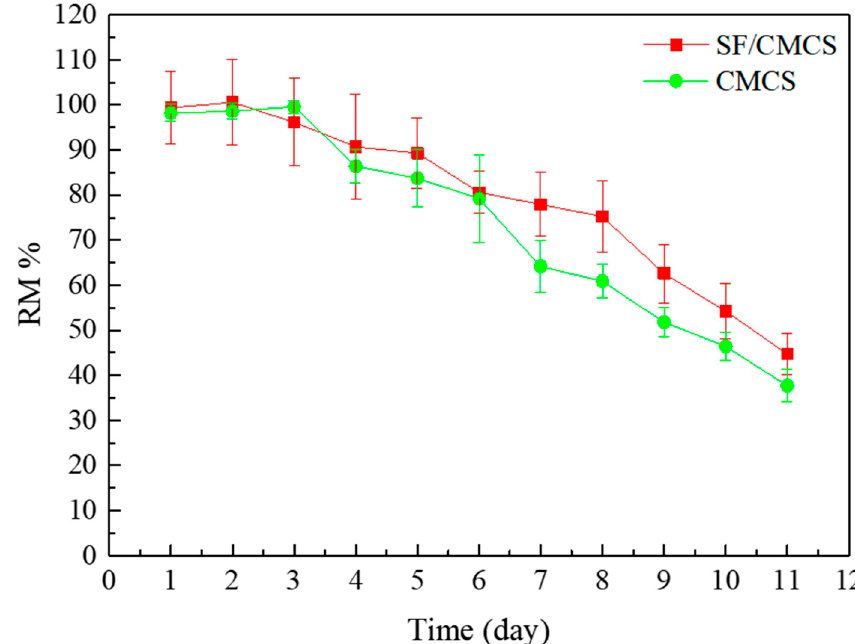
Figure 7. The degradation profiles of SF/CMCS and CMCS hydrogels.